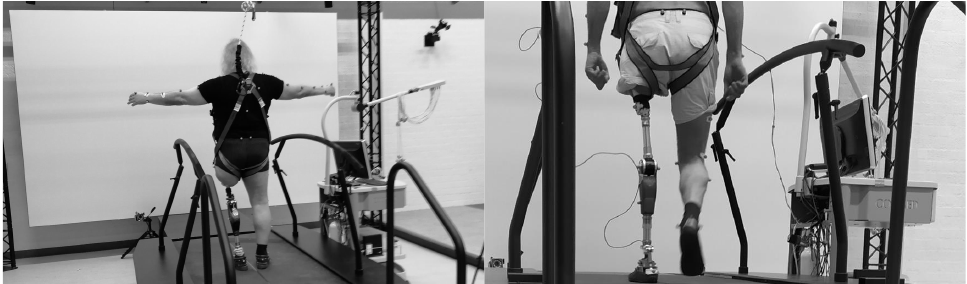
Figure 5. Treadmill test: the participant’s movements are measured thanks to the reflective markers placed on their skin. The participant wore a harness for